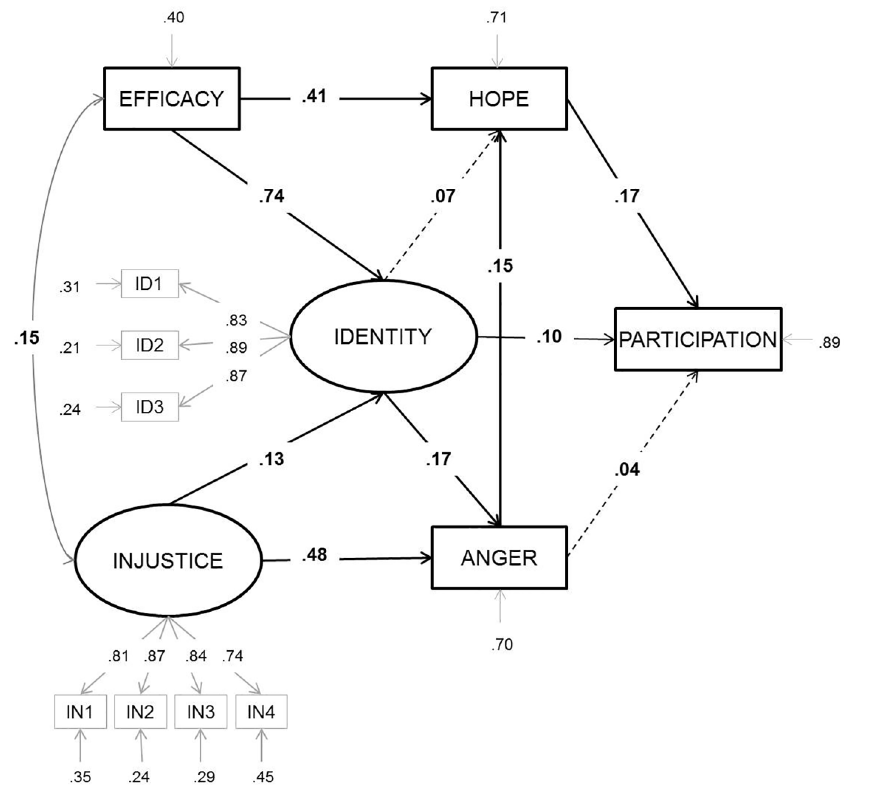
Figure 2. Model 2 – Alternative sequential mediation models based on the Encapsulated Model of Social Identity in Collective Action (EMSICA) with hope and anger as mediators between collective action frames and intensity of participation. Note. Path coefficients are standardized estimates. Significant covariances between latent factors are shown by double-arrowed solid lines. All the coefficients represented by continuous arrows in the graphs are statistically significant based on 95% bootstrapped confidence intervals, while the dashed lines indicate effects that are not statistically